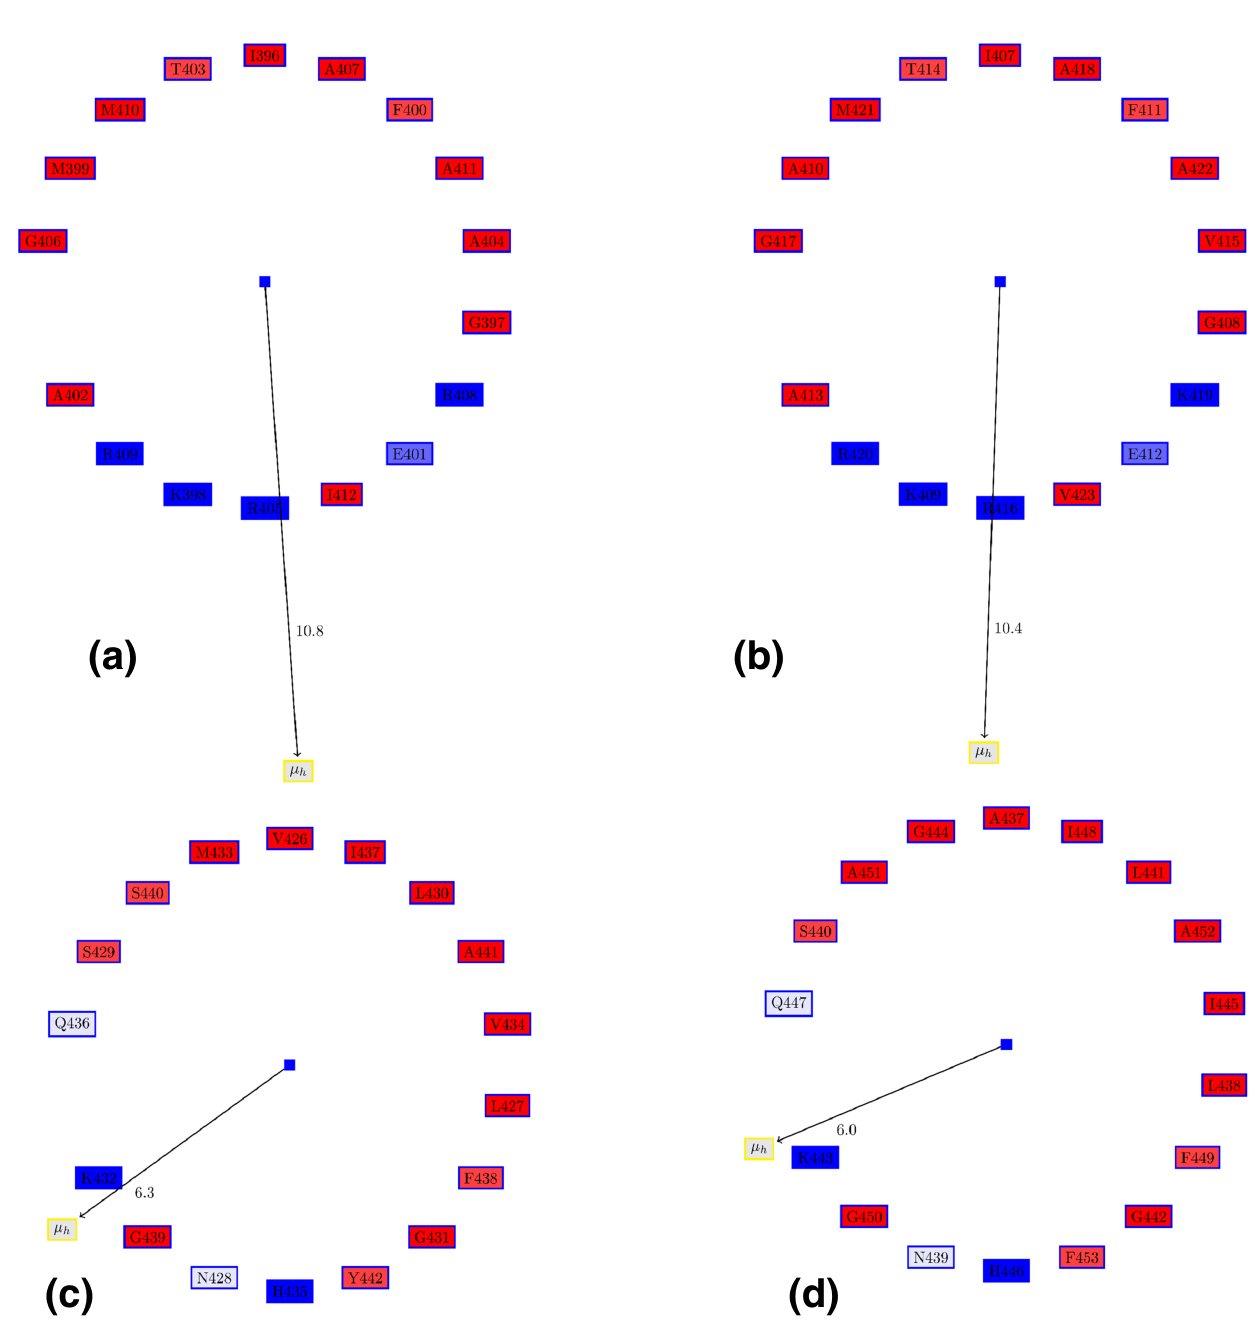
Figure 6. Edmundson wheel of the cationic amphipathic α -helices in the stem region of ZIKV-E (PDB ID:5IREA) and DENV3-E (PDB ID:3J6SA) proteins. ( a ) α 3 in DENV-E protein. ( b ) α 3 in ZIKV-E protein. ( c ) α 4 in DENV-E protein. ( d ) α 4 in ZIKV-E protein. The Edmundson wheel shows the amphipathic cationic nature of the stem helices. The hydrophobicity of residues in the hydrophobic face is an important determinant of virulence 63,72,73 . The conservation of the charged face of α 4 ( c and d ) is in contrast to several differences in the hydrophobic face. The color coding for the Edmundson wheel is as follows: all hydrophobic residues are colored red, while hydrophilic residues are colored in blue: dark blue for positively charged residues, medium blue for negatively charged residues and light blue for